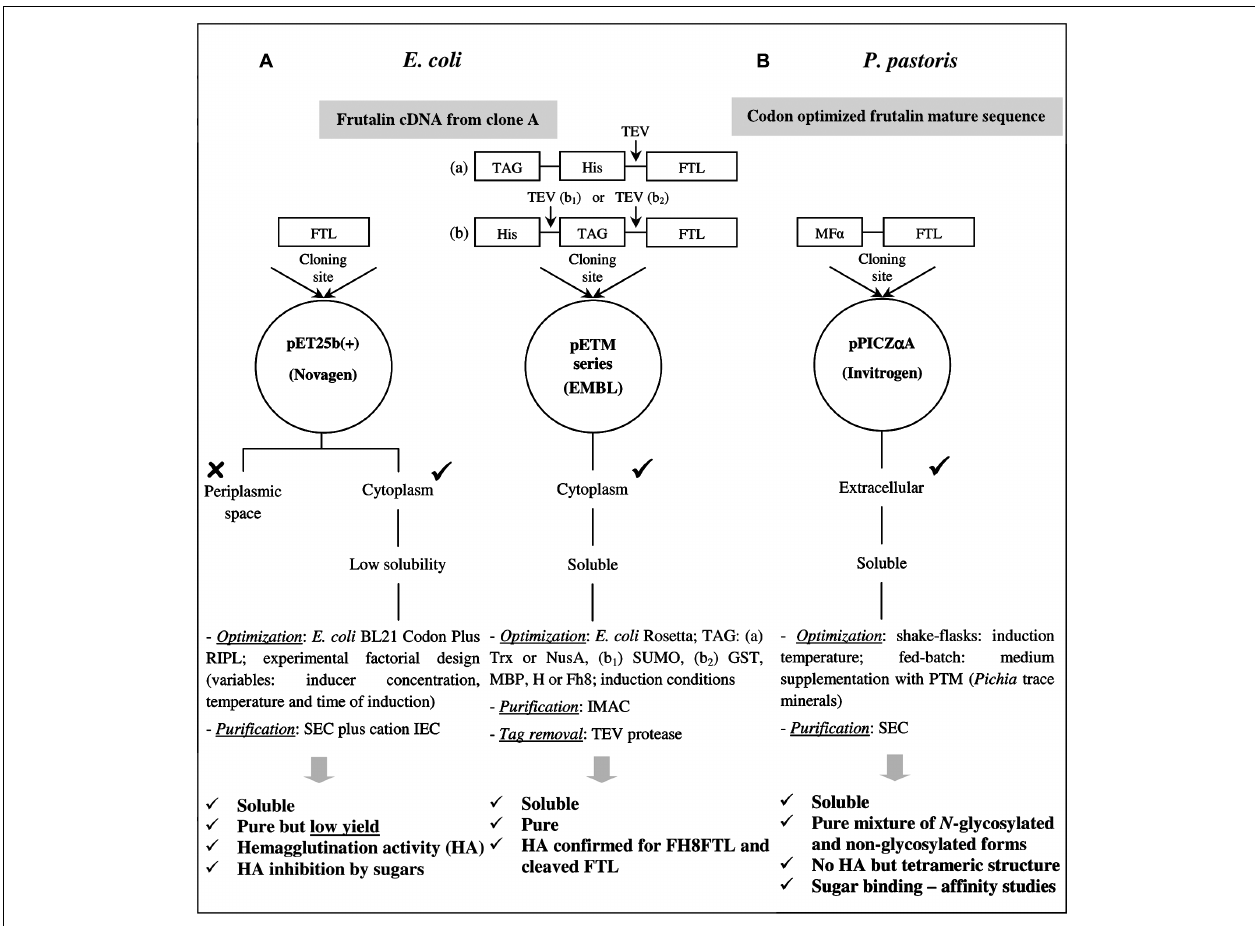
FIGURE 1 | Main strategies for the production of soluble recombinant FTL in Escherichia coli (A) and Pichia pastoris (B). Different frutalin codifying genes were cloned in E. coli and P. pastoris , which deduced amino-acid sequences share 93% of identity (Table 2 in Oliveira etal.,